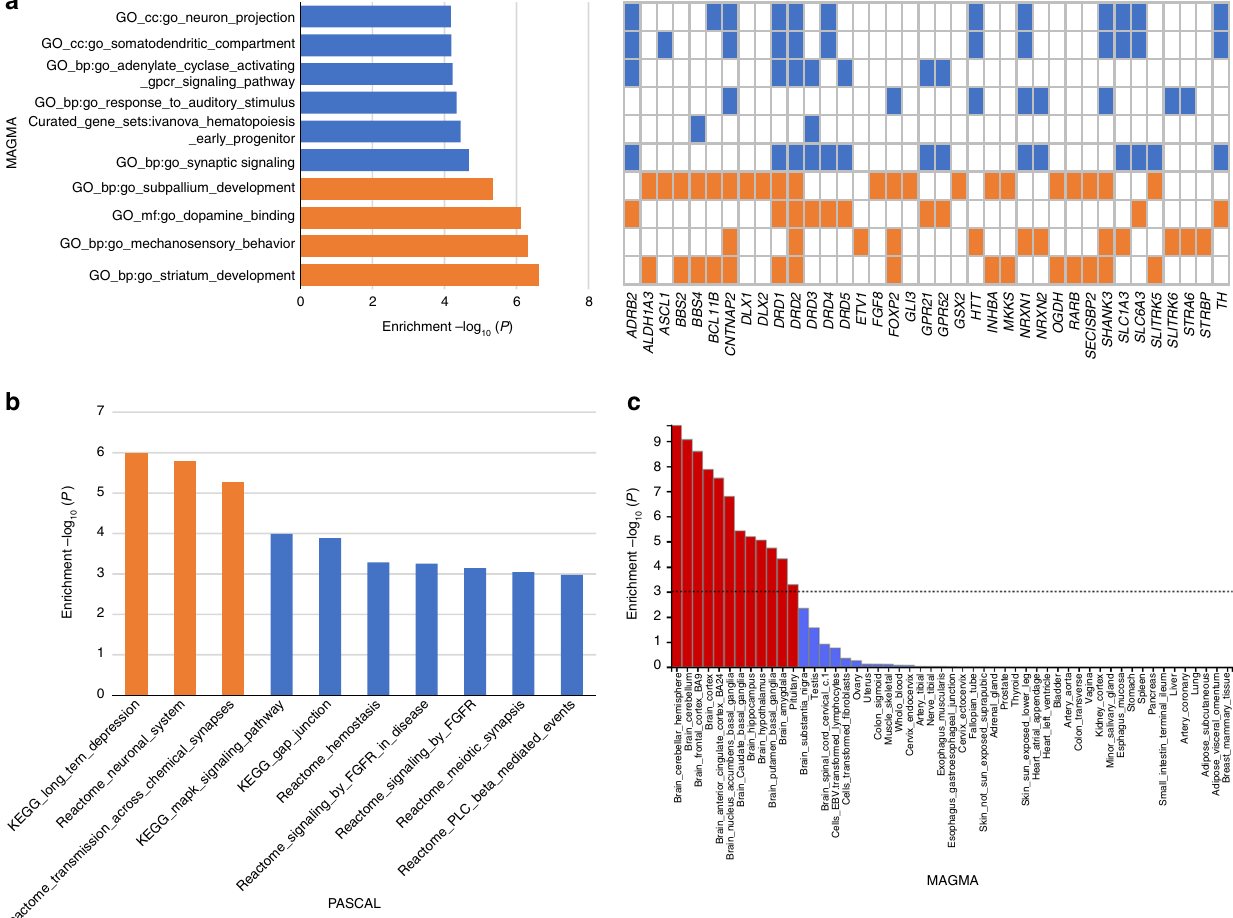
Fig. 2 Pathway-based and tissue expression enrichment analyses for sleep duration. a Pathway analysis is based on MAGMA gene sets. Top 10 of 10,891 pathways are shown, and signi fi cant pathways are indicated in orange ( P < 4.59 × 10 − 6 ). For each signi fi cant pathway, respective sleep genes are indicated with a colored orange box. Sleep genes from signi fi cant pathways that overlap with remaining pathways are indicated in blue. b Pathway analysis is based on Pascal (gene-set enrichment analysis using 1077 pathways from KEGG, REACTOME, BIOCARTA databases). Top 10 pathways are shown, and signi fi cant pathways are indicated in orange ( P < 4.64 × 10 − 5 ). c MAGMA tissue expression analysis using gene expression per tissue based on GTEx RNA- seq data for 53 speci fi c tissue types. Signi fi cant tissues are shown in red ( P < 9.43 × 10 − 4 ). All pathway and tissue expression analyses in this fi gure can be found in tabular form in Supplementary Tables 9, 10,